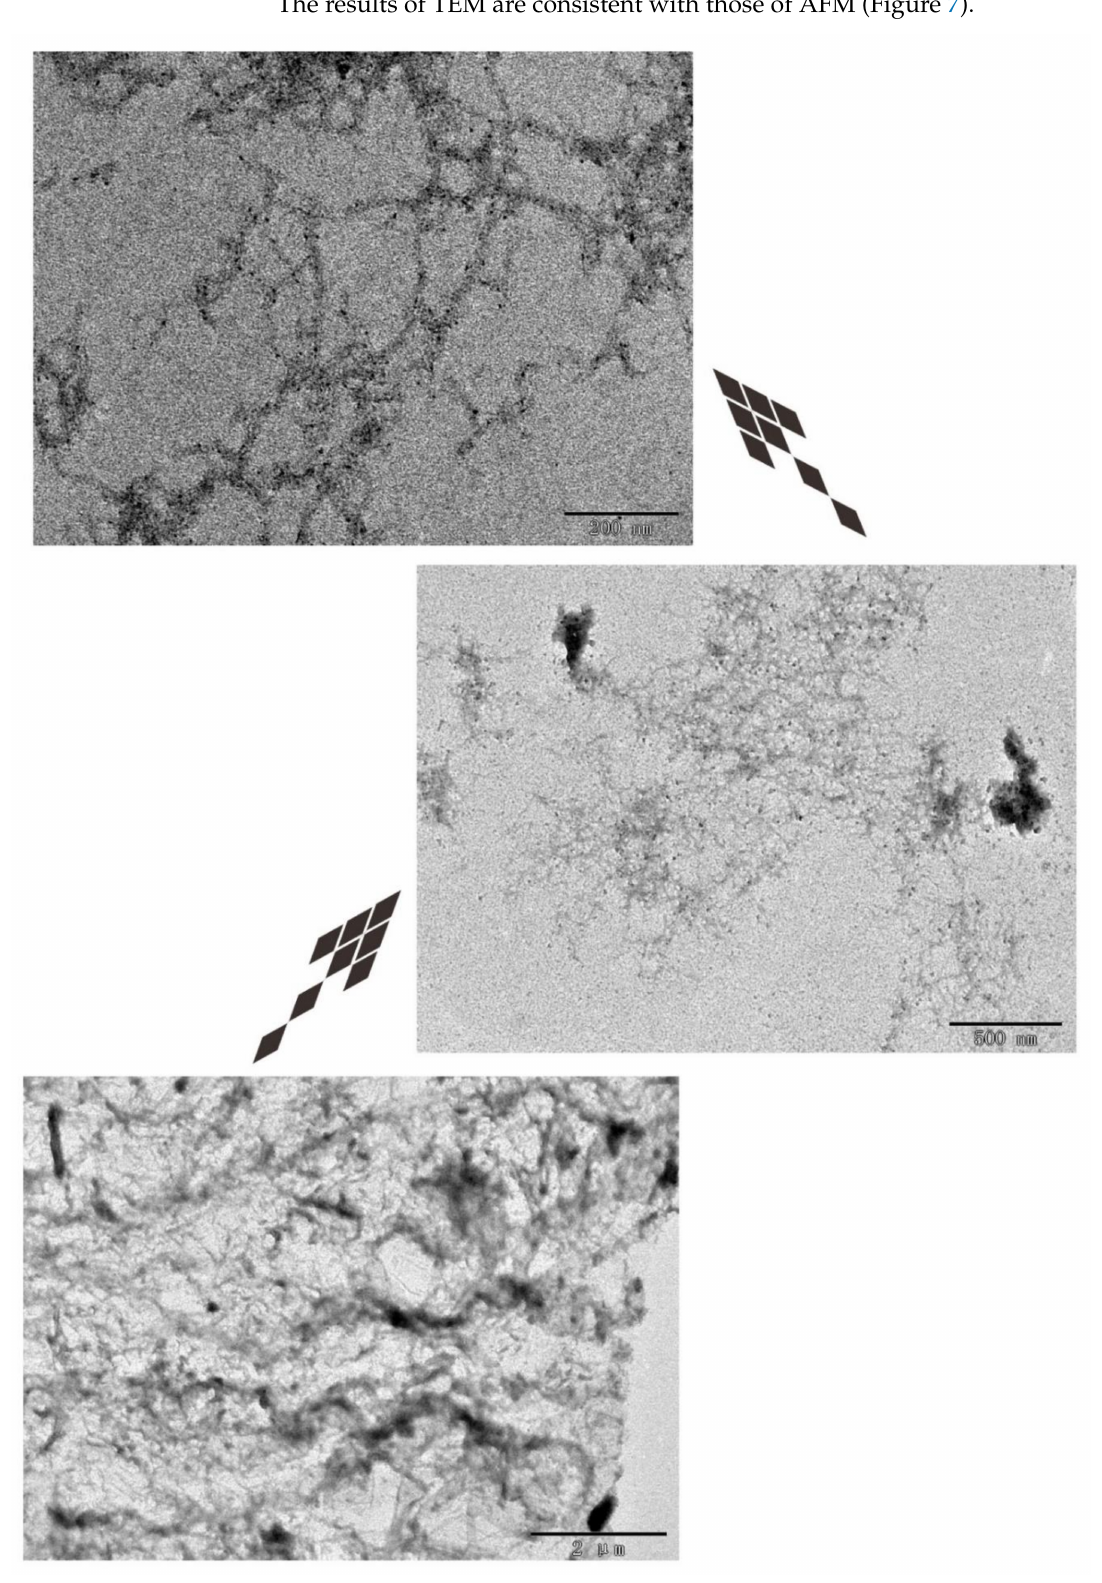
Figure 7. Transmission electron microscopy (TEM) analysis of